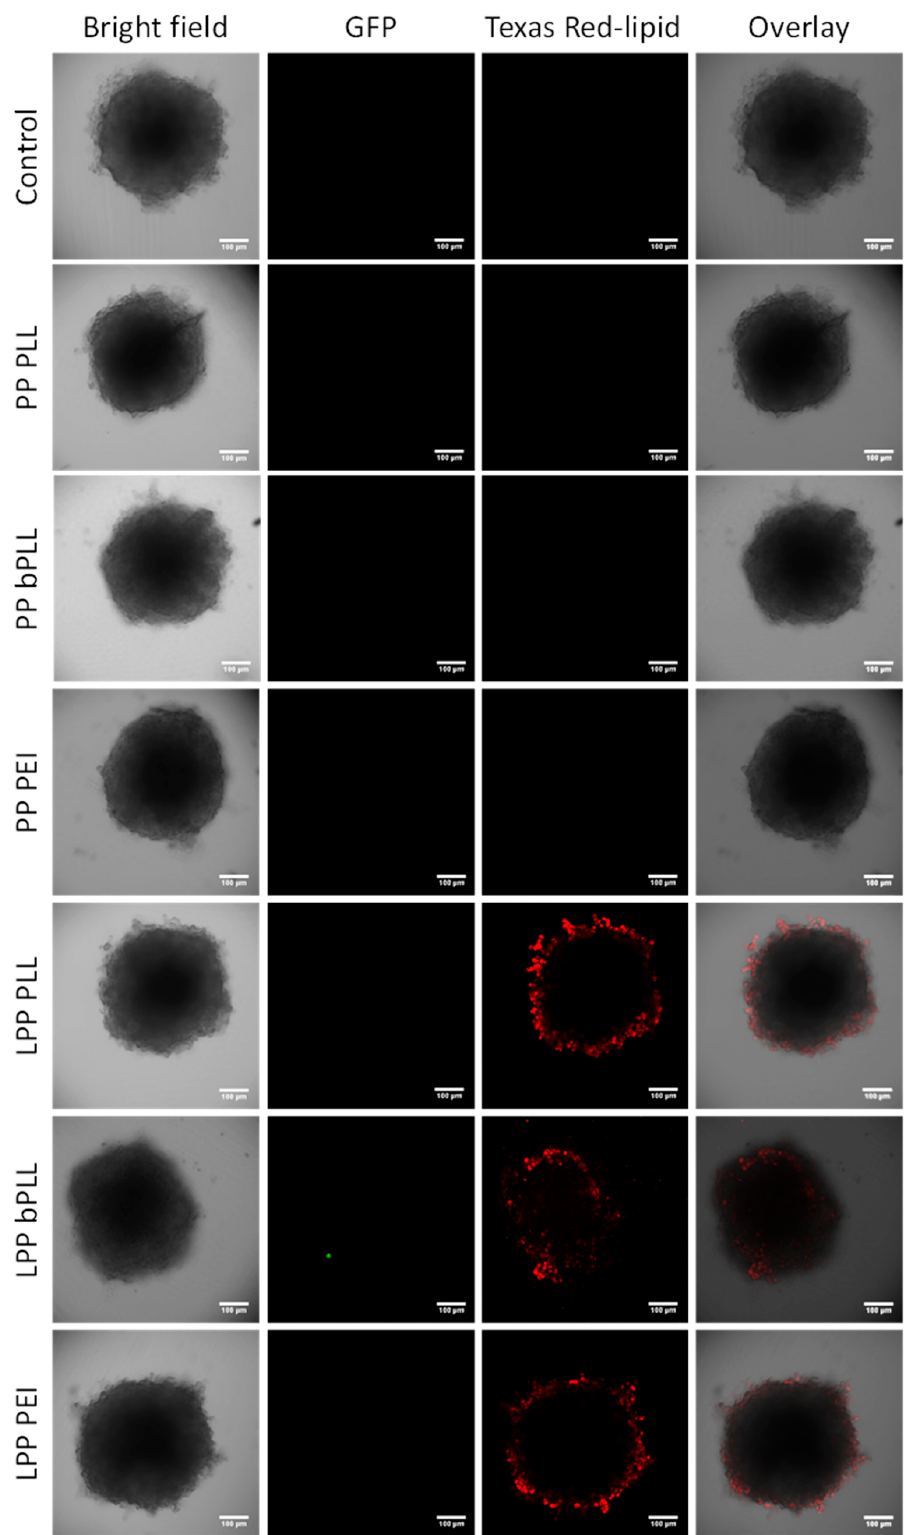
Figure 5. Confocal microscopy images of A549 cells in 3D multicellular spheroid culture 3 d after incubation with PPs and LPPs. The figure shows, from left to right, for each treatment: bright-field image, GFP fluorescence (green) as an indicator of transfection activity, Texas Red lipid fluorescence (red) reporting about the depth of penetration, and overlay of the three previous images.